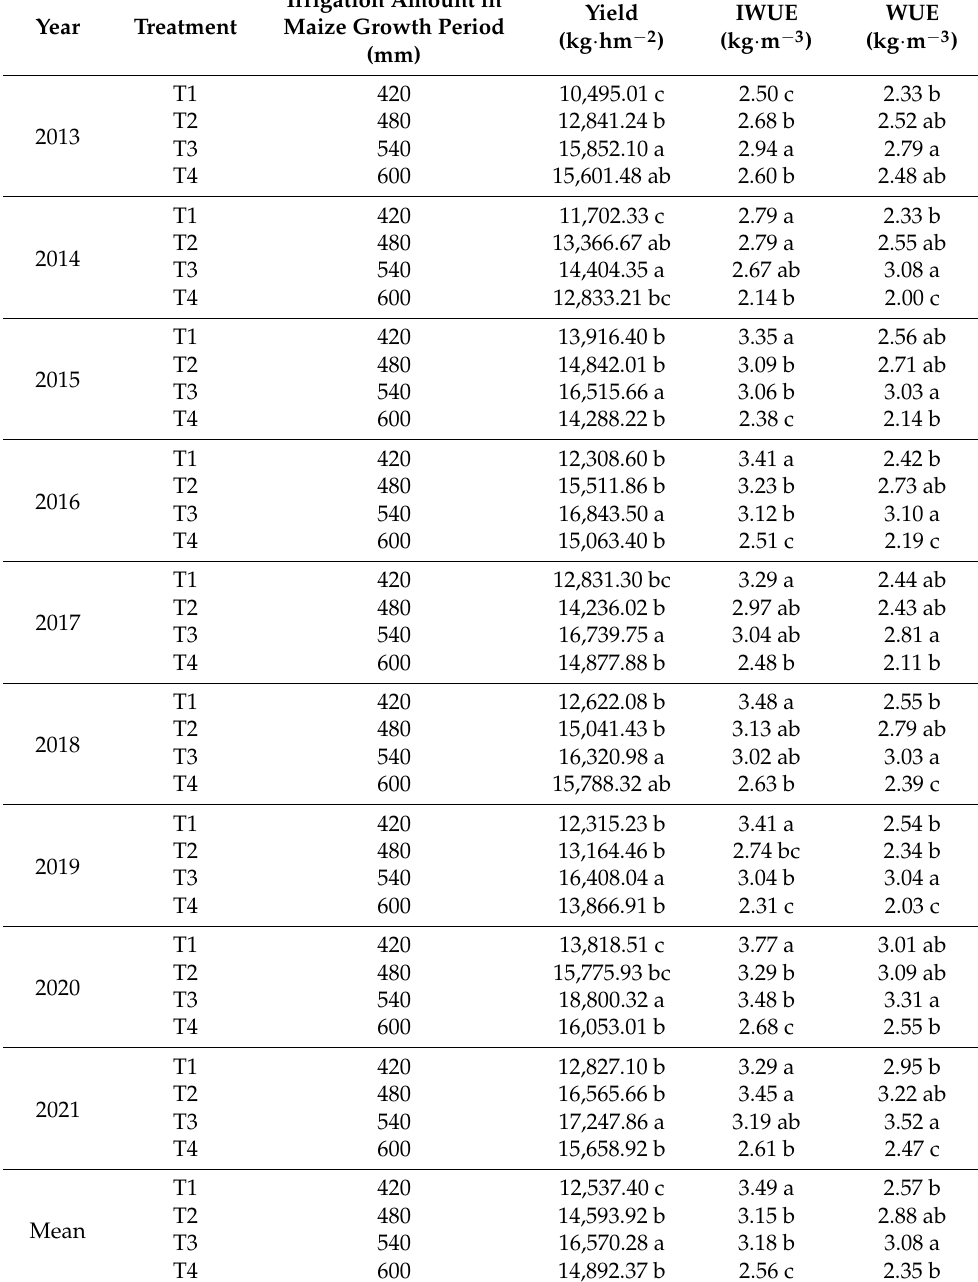
Table 7. WUE of drip irrigated maize under different irrigation